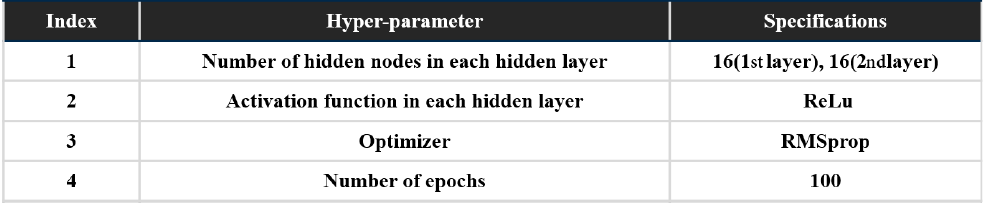
Figure 11. Optimized hyper-parameter